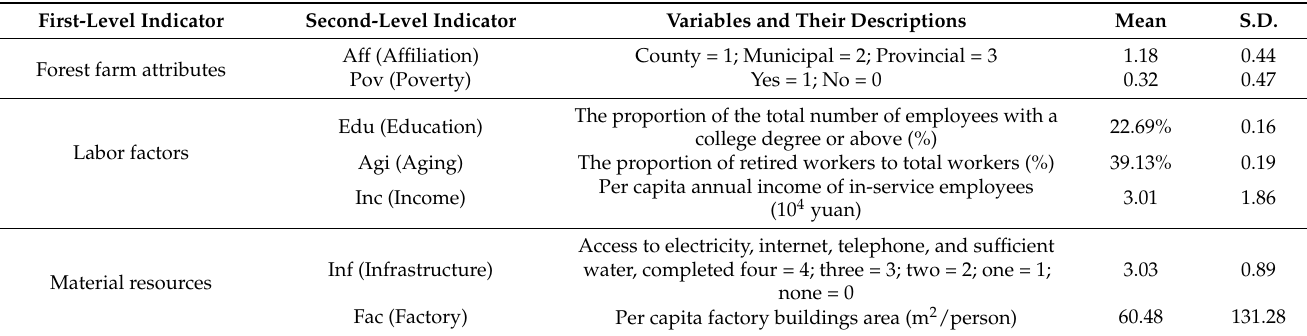
Table 1. Description of environment